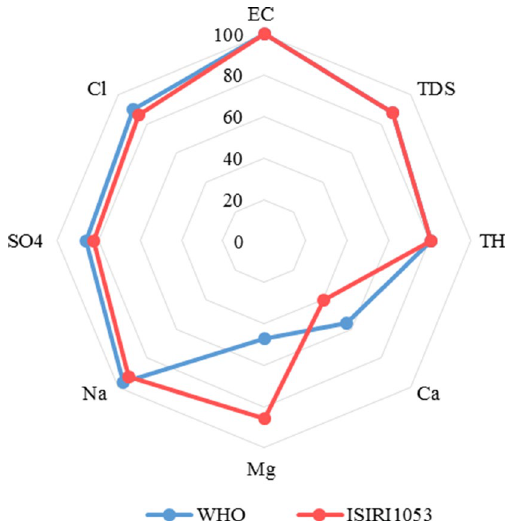
Fig. 8 Percentage of physicochemical parameters above the permis- sible limit for WHO and ISIRI1053